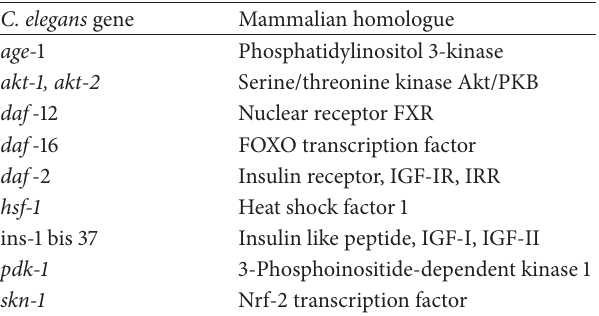
Table 4: Regulatory ageing-associated genes in C. elegans and their mammalian homologues.